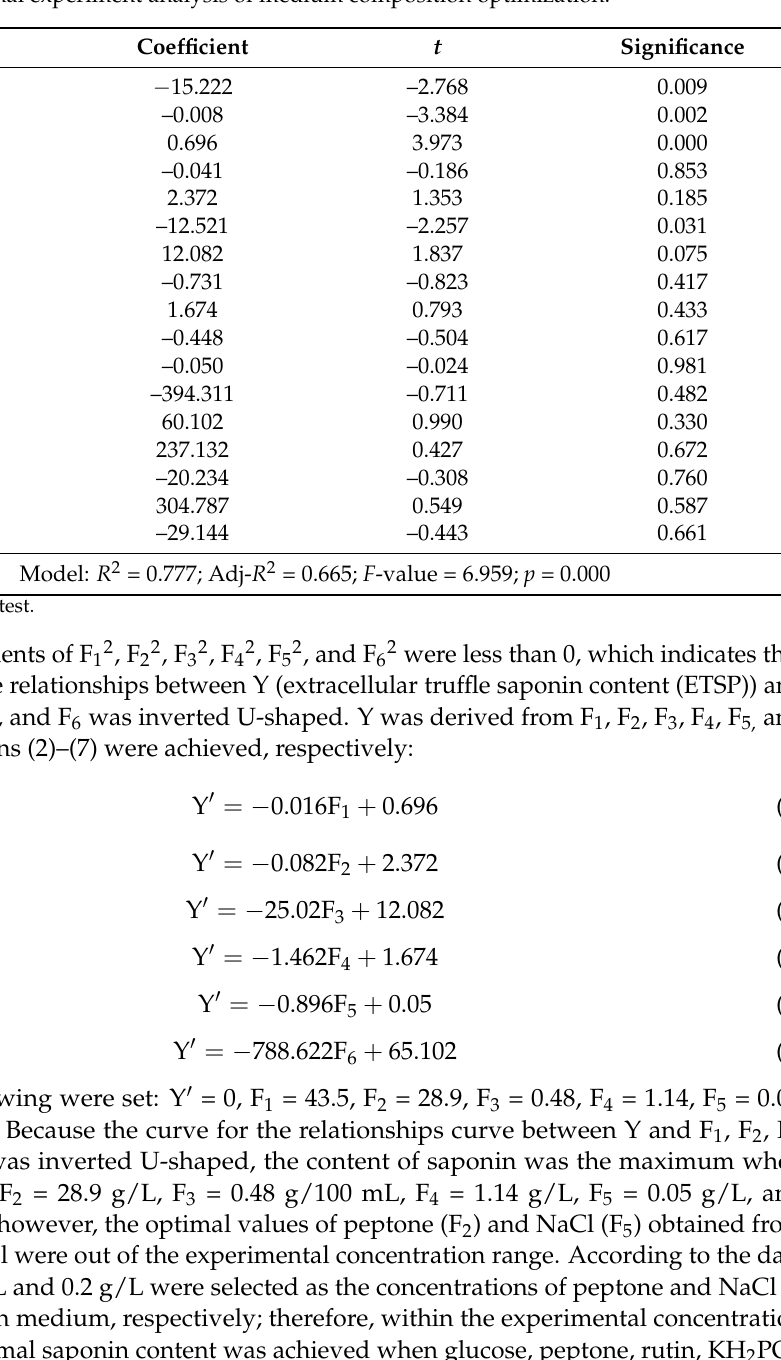
Table 5. Orthogonal experiment analysis of medium composition